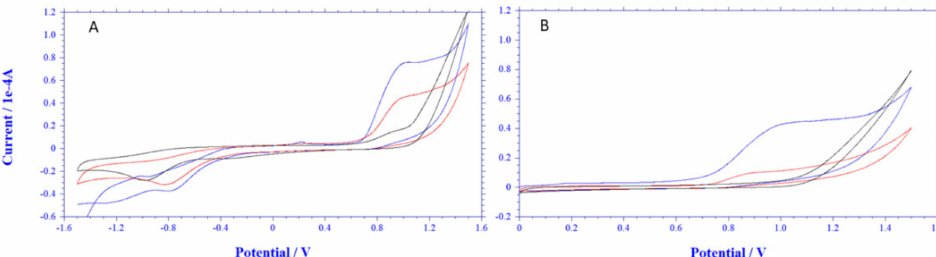
Figure 3. Current-potential curves of 5 mM of terbutaline (blue line 1st cycle, red line 10th cycle) at a glassy carbon electrode in 20 mM of acetic acid/acetonitrile (55:54 v / v ), pH 7.0 supporting electrolyte (black line). Scan rate: 100 mV.s − 1 . Potential range: ( A ) − 1.5/+1.5 V; ( B ) 0/+1.5